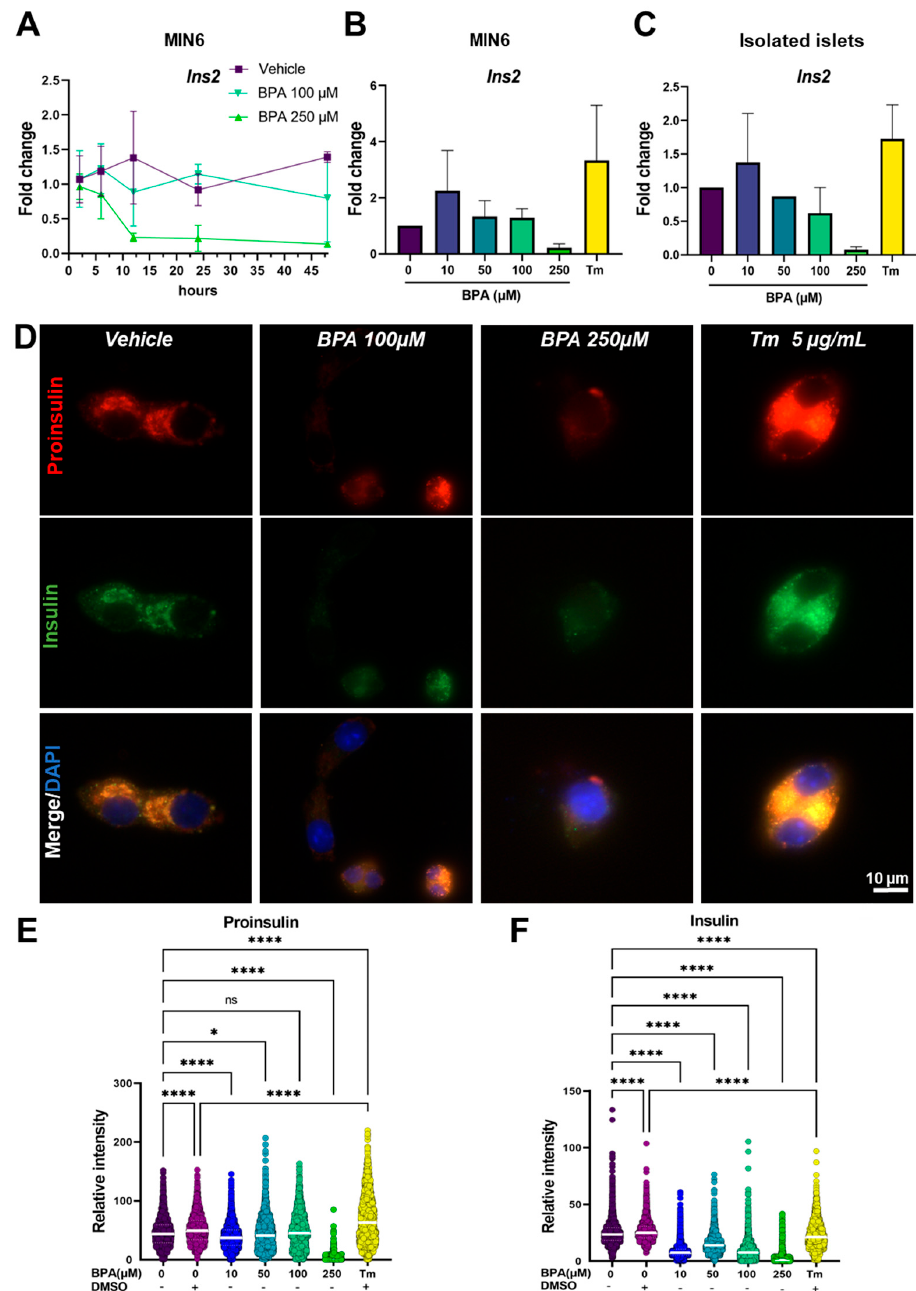
Figure 3. Insulin processing is affected by BPA and Tm in MIN6 cells and isolated islets. ( A ) Time course of BPA-induced Ins2 gene expression at different time points (2, 6, 12, 24, 48 h) in MIN6 cells. RT-qPCR analysis of the Ins2 gene in MIN6 cells ( B ) and isolated islets ( C ) after 24 h of treatment with different concentrations of BPA and 5 µg/mL Tm. Fold change values were calculated by normalization to Gapdh and then to the NT values. ( D ) Representative fluorescence microscopy images with MIN6 cells after 24 h of treatment with 100, 250 µM BPA and 5 µg/mL Tm, marked for proinsulin (red) and insulin (green). The nucleus was stained with DAPI. ( E ) Graphic representation of the mean intensity of the red fluorescent channel (proinsulin) and ( F ) the mean intensity of the green fluorescent channel (insulin) per cell ( n > 200 cells) in MIN6 cells after 24 h of treatment with increasing concentrations of BPA (as shown) and 5 µg/mL Tm. The mean intensity was determined with QuPath. Graphs display the median and the 25th and 75th percentiles. * p < 0.05, **** p < 0.0001, ns—not significant, based on one way ANOVA.